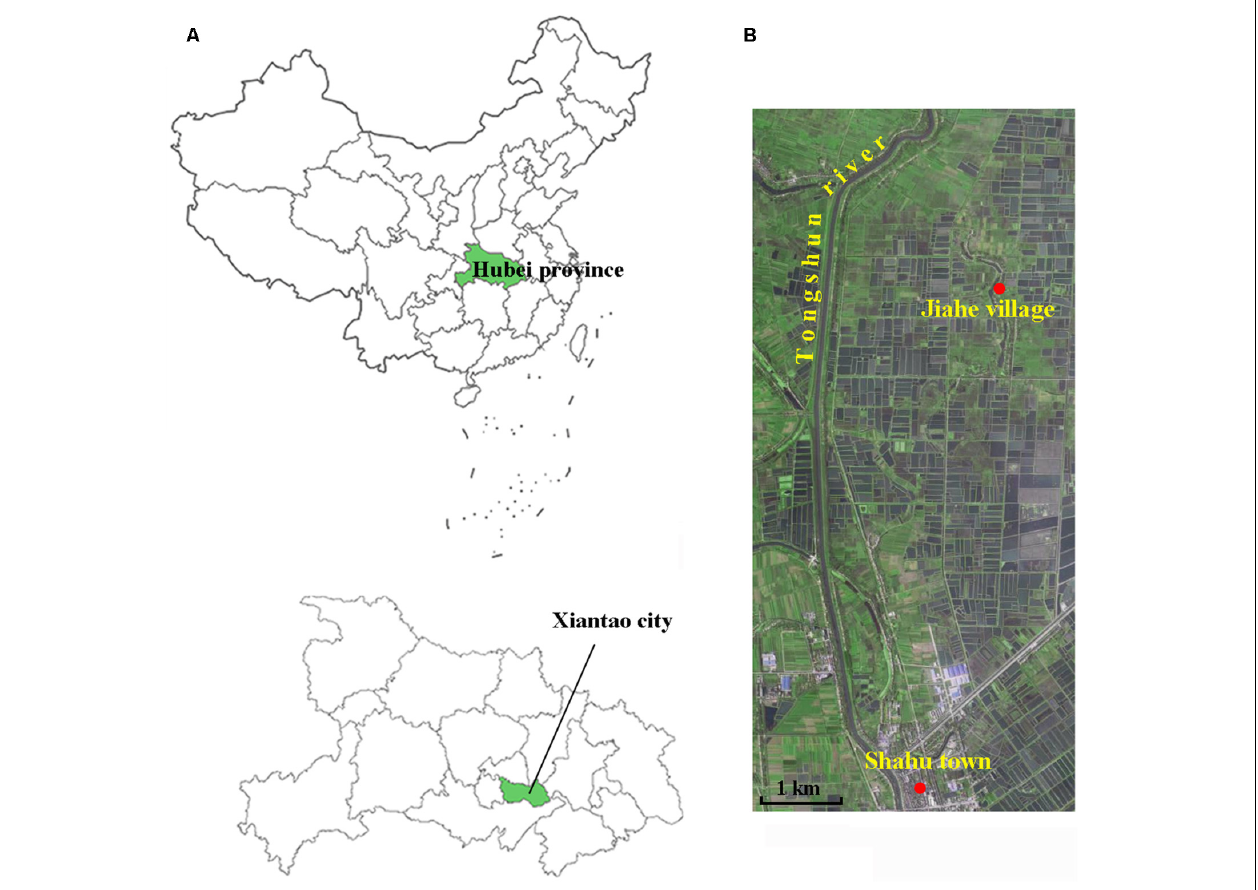
FIGURE 1 | Illustrations of the sampling site. (A) Geographical map of the sampling location in the Jiahe village of the Shahu town in Jianghan Plain. (B) Satellite map of the sampling